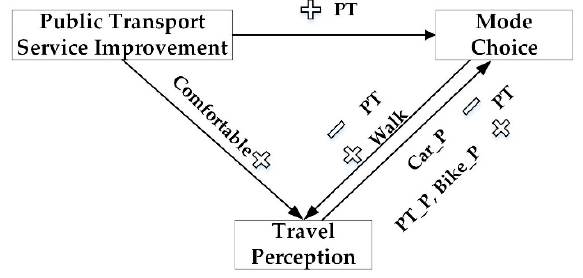
Figure 6. Relationship among public transport service improvement, mode choice, and travel perception. (Note ：